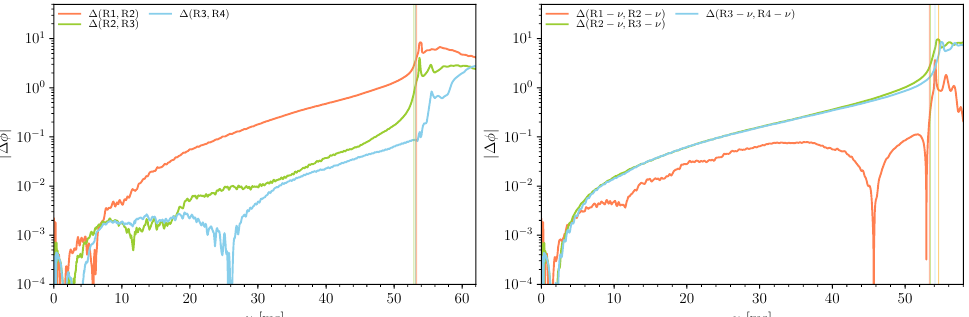
Figure A2. Phase difference of the ( 2,2 ) mode of the GW signal between different resolutions with respect to the retarded time u . The BHB Λ φ case is presented on the left panel and the BHB Λ φ - ν case is presented on the right panel. Solid vertical lines mark the merger for each